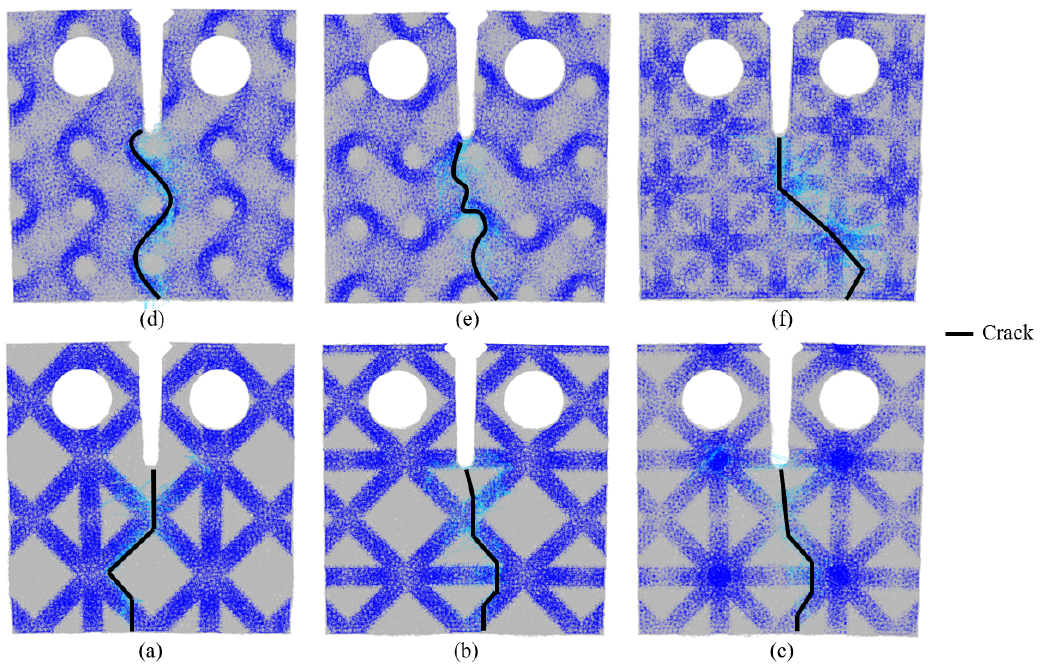
Figure 12. Crack paths in the MS-TiC inserts according to the failure stress of the DEM bonds. The blue color of the bonds corresponds to the MS-TiC failure stress. Gyroid_01 ( a ), Gyroid_02 ( b ), octet-truss ( c ), FBCZZ_01 ( d ), FBCCZ_02 ( e ) and FBCCZ_03 ( f